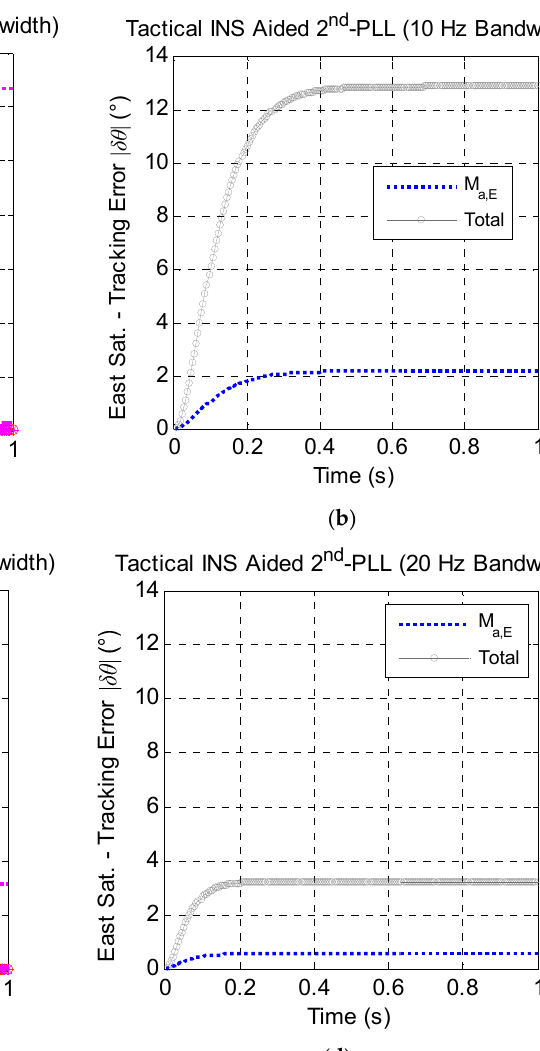
( d ) Figure 7. The east satellite tracking error caused by MEMS INS error sources under the assumption of linear high dynamics along the north direction. ( a ) Effect of non-maneuver-dependent error with a 10-Hz bandwidth; ( b ) effect of maneuver-dependent error with a 10-Hz bandwidth; ( c ) effect of non-maneuver-dependent error with a 20-Hz bandwidth; ( d ) effect of maneuver-dependent error with a 20-Hz bandwidth. (* Here, Sat. is the abbreviation of satellite.)